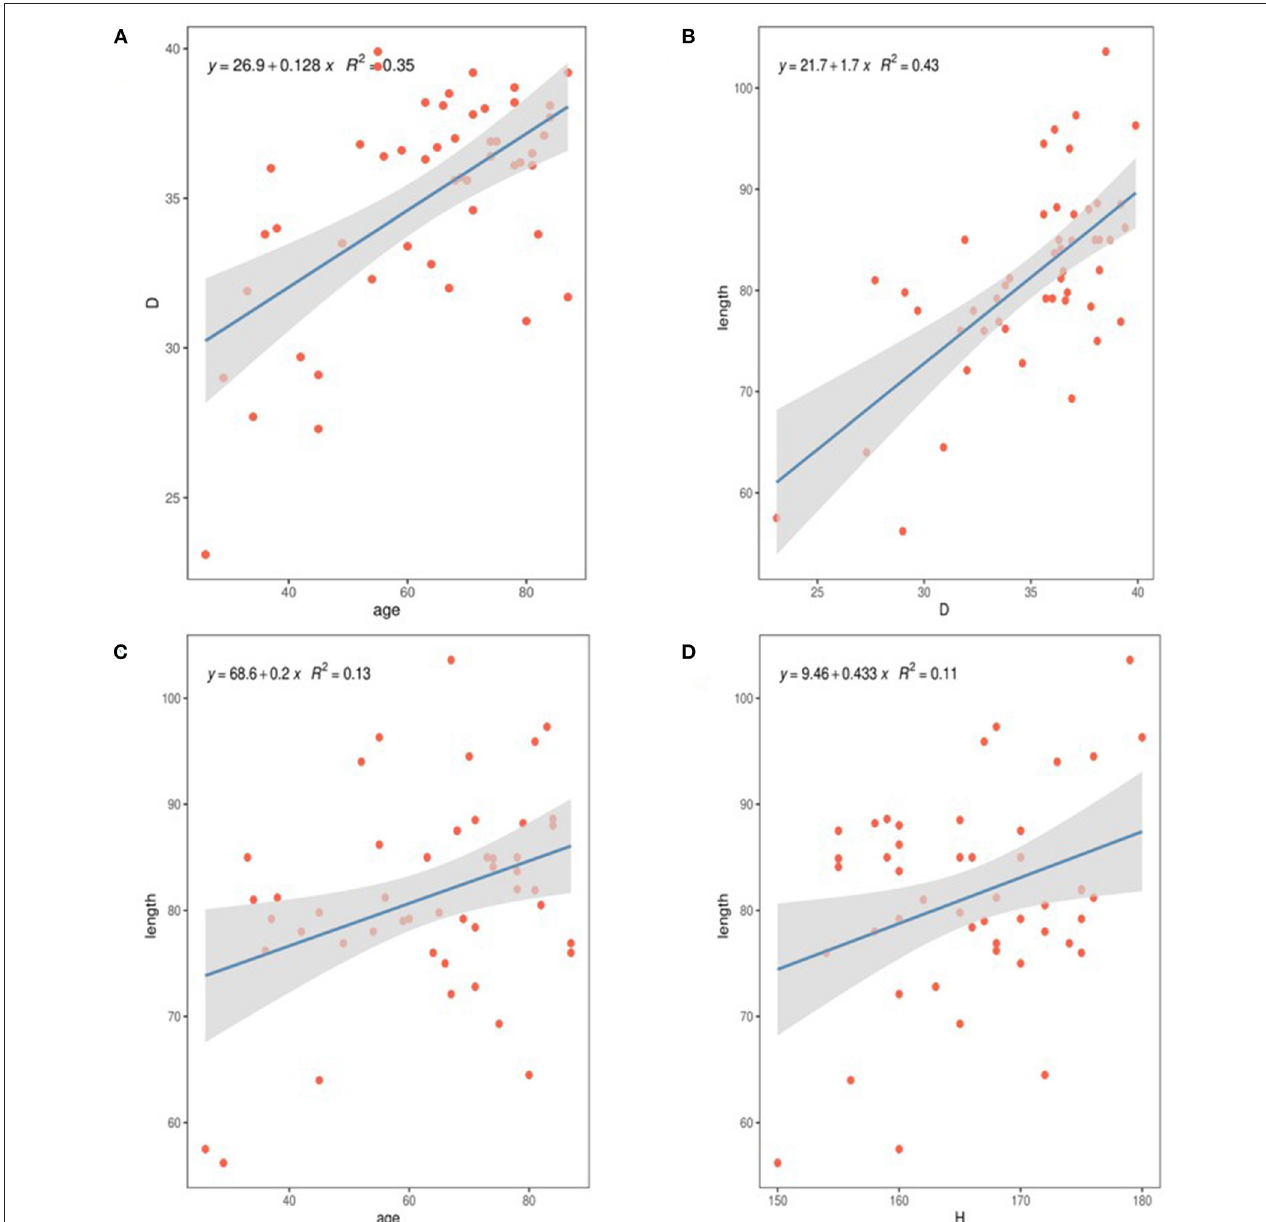
FIGURE 2 | The relationship of diameter and length in normal ascending aortas with clinical variables. (A) The diameter of the ascending aorta correlates with increasing age. (B) The diameter of the ascending aorta correlates with increasing AAL. (C) The AAL was correlates with increasing age. (D) The AAL was correlates with increasing